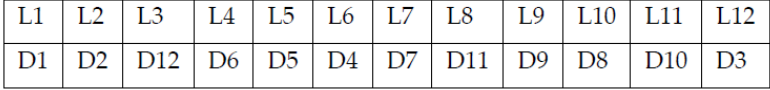
Figure 2. Gene representation in terms of locations and departments.